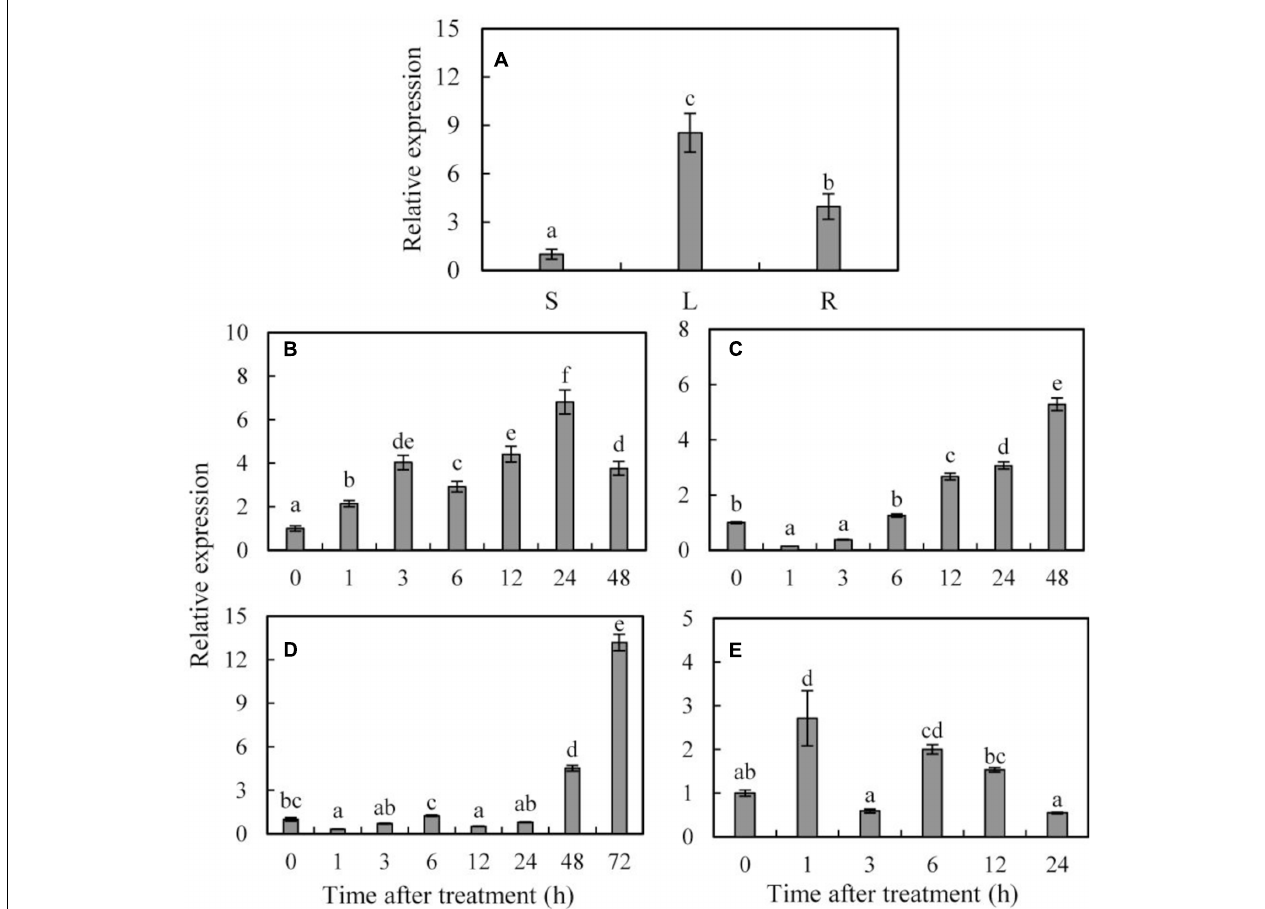
FIGURE 1 | Organ expression assay of SoCYP85A1 and expression profiles of SoCYP85A1 under treatments with PEG, ABA, 4 ◦ C and NaCl. (A) Organ expression assay of SoCYP85A1 in spinach. The organs (stem, leaf, and root) are represented by S, L, and R, respectively. (B) 20% PEG6000; (C) 100 µ M ABA; (D) 4 ◦ C; (E) 200 mM NaCl. The expression level of stem for organ expression assay and for stress assay at time point 0 were defined as 1. Error bars represent standard deviations (SD) for three independent replicates with different letters at P < 0.05 significant level.